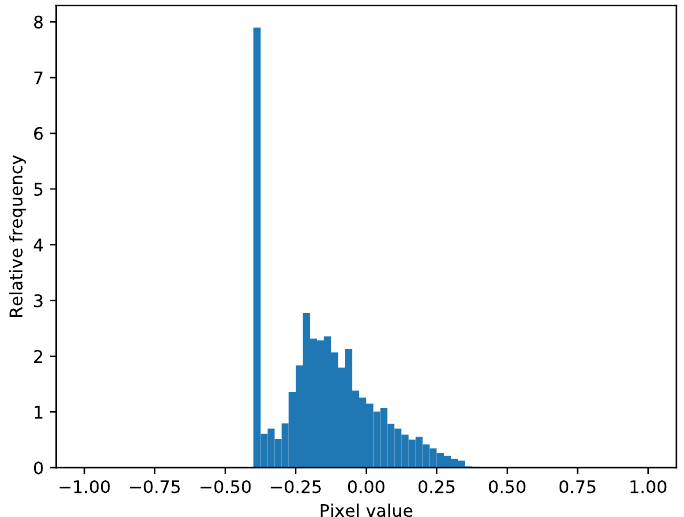
Figure 4. Histogram of the ray-traced snippets pixel